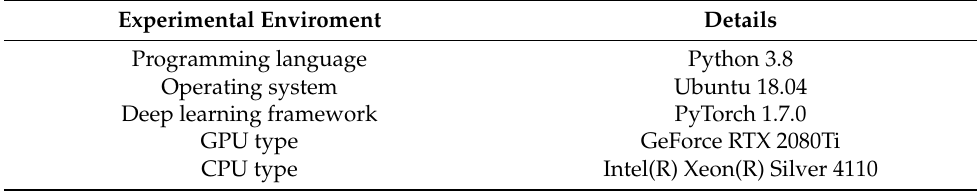
Table 3. Experimental condition configuration.